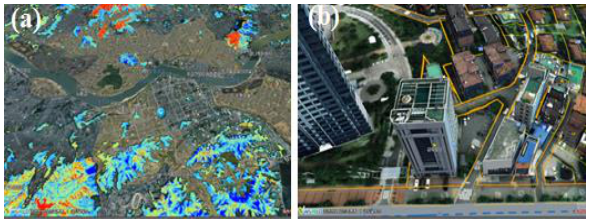
Figure 9. Indoor 3D Geospatial Views in V-world